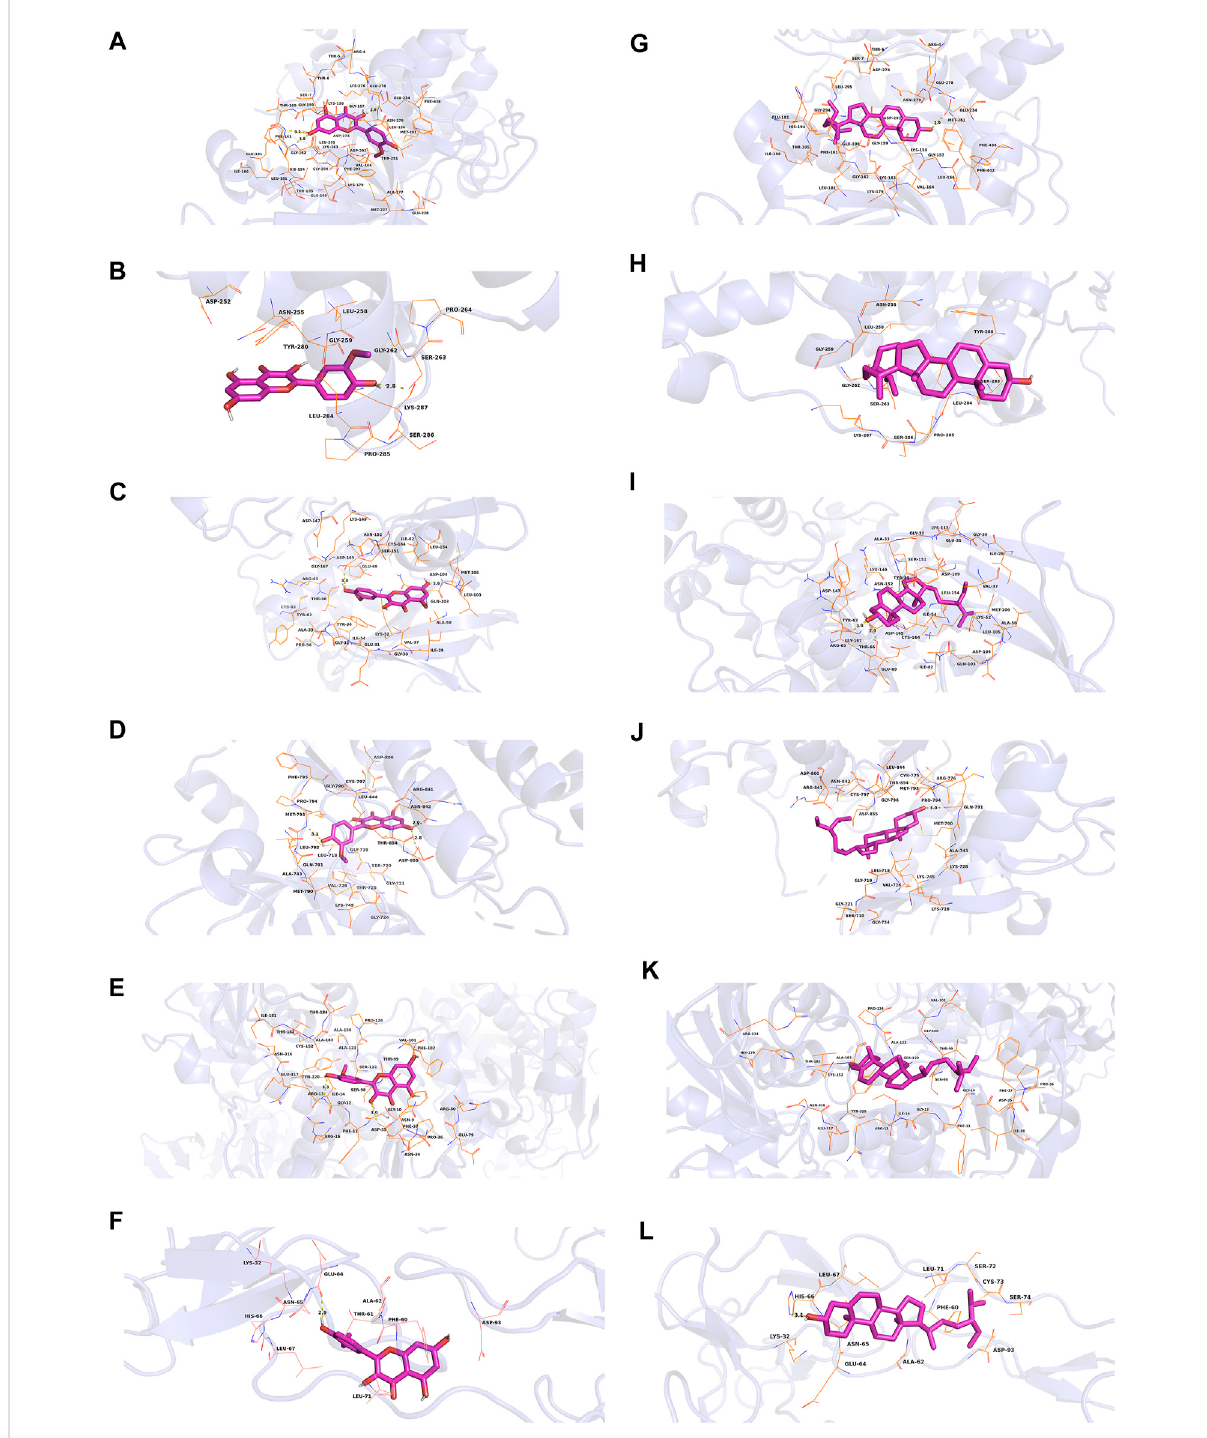
FIGURE 8 Molecularmodelsofisorhamnetinandbeta-sitosterolthatbindtothepredictedproteintargets,shownas3Ddiagrams. (A) isorhamnetin-AKT1, (B) isorhamnetin-MAPK3, (C) isorhamnetin-MAPK1, (D) isorhamnetin-EGFR, (E) isorhamnetin-GAPDH, (F) isorhamnetin-TNF, (G) beta-sitosterol- AKT1, (H) beta-sitosterol-MAPK3, (I) beta-sitosterol-MAPK1, (J) beta-sitosterol-EGFR, (K) beta-sitosterol-GAPDH, (L)